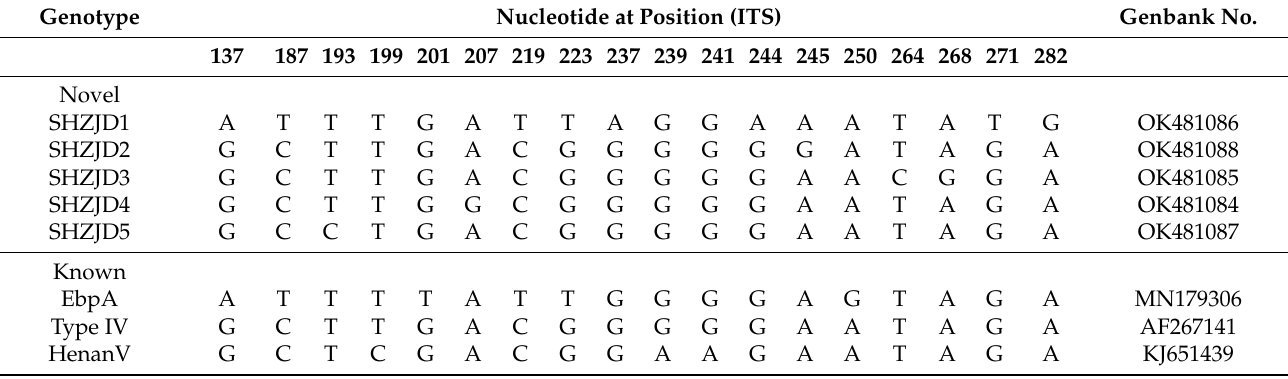
Table 2. Variation of the ITS gene sequences of E. bieneusi isolates in dogs.